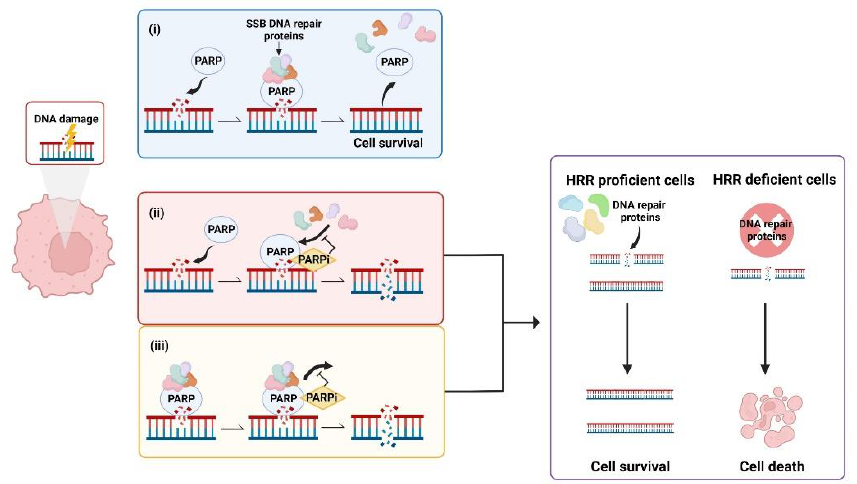
Figure 1. Synthetic lethality occurs when a defect in the homologous recombination repair (HRR) pathway is combined with inhibition of poly (ADP-ribose) polymerase (PARP). ( i ) PARP binds to sites of single strand breaks (SSBs), PARylates substrates and recruits DNA repair proteins. ( ii ) PARP inhibitors (PARPis) bind PARP, preventing PARylation and blocking access of PARP to DNA lesions that results in double strand breaks (DSBs). ( iii ) PARPis can also work to trap PARP at the DNA, inhibiting the dissociation of PARP from DNA and leading to the generation of DSBs. In cells with defective HRR, DSBs are unable to be repaired, leading to cell death. Created with Bioren- der.com. 2. PARP Inhibitors (PARPis) — Focus on Ovarian Cancer PARP inhibitors (PARPis) including olaparib (Lynparza ® ; AstraZeneca Pharmaceu- ticals, Cambridge, UK), rucaparib (Rubraca ® ; Clovis Oncology, Inc., Boulder, CO, USA) and niraparib (Zejula ® ; GlaxoSmithKline, Brentford, Middlesex, UK) are small molecule inhibitors of PARP that have been approved by the US Food and Drug Administration (FDA), and other regulatory authorities worldwide, for women with ovarian cancer under certain conditions, including as maintenance therapy. Talazoparib (Talzenna ® ; Pfizer, Inc., Manhattan, NY, USA) is approved for treatment of advanced breast cancer and veliparib (ABT-888; AbbVie, North Chicago, IL, USA) is still being evaluated. An additional two PARPis, pamiparib (Partruvix ™ ; BeiGene Ltd., Beijing, China) and fuzuloparib (AiRuiYi ® , formerly fluzoparib; Jiangsu Hengrui Pharmaceuticals Co., Ltd., Lianyungang, China), have been approved in China for the treatment of women with ovarian cancer. 2.1. Timeline of Discovery and Clinical Adoption of PARPis In 1963, Chambon and colleagues reported their initial discovery that nicotinamide mon- onucleotide enhanced the activity of a DNA dependent enzyme [55,56]. This discovery would go on to form the basis of the PARP field as we know it today. By the early 1980s, PARP had been found to play an essential role in the repair of DNA SSBs and the first PARPi was identified [57 – 59]. In 2005, the landmark discovery that BRCA dysfunction greatly sensitised cancer cells to PARP inhibition was reported [60,61]. This was proof that the concept of synthetic lethality could be adopted as a therapeutic strategy by targeting BRCA-related HRR dysfunction with a DNA repair inhibitor. For malignancies such as HGSOC where BRCA1 and BRCA2 mutations are prevalent [14], this discovery marked a clear turning point and new hope for molecular targeted therapy. Almost a decade later in December 2014, olaparib became the first PARPi approved by the FDA for the treatment of advanced, recurrent ovarian cancers with germline BRCA mutation, or suspected germline mutation, and previous treatment of three or more lines of chemotherapy [62,63]. FDA approval of rucaparib followed in 2016, for treatment of the same indication [51,64]. Niraparib was approved by the FDA in 2017 for maintenance